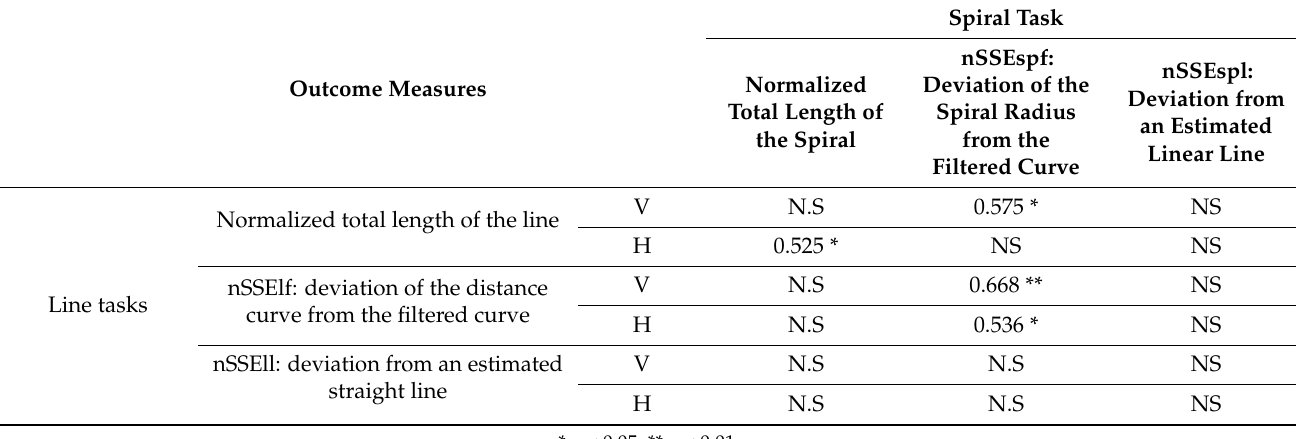
Table 4. Results of correlation analysis for the ET group between spiral, vertical (V), and horizontal (H) line tasks ( n =